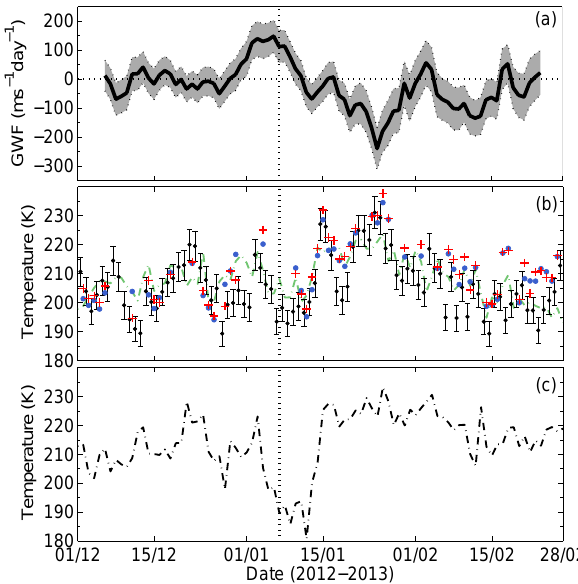
Figure 1. (a) 10-day moving average GW forcing (in ms − 1 day − 1 at ∼ 90km over Trondheim, derived from meteor radar observations (from de Wit et al., 2014b). (b) Trondheim meteor radar tempera- tures ( ∼ 90km, black dots), Trondheim OH airglow temperatures ((3,1)-band, red crosses; (4,2)-band, blue dots, both ∼ 87km), and MLS temperatures in a 15 ◦ × 15 ◦ area centred around Trondheim (0.002hPa, ∼ 86km, green dash-dotted line) for the 2012–2013 winter. (c) MLS temperatures in a 15 ◦ × 15 ◦ area centred around Trondheim at 0.01hPa ( ∼ 79km). The onset of the major SSW on 7 January (defined as the day the zonal mean 4-day moving aver- age zonal wind at 60 ◦ N, 10hPa reversed direction (de Wit et al., 2014b)) is indicated with a vertical dotted